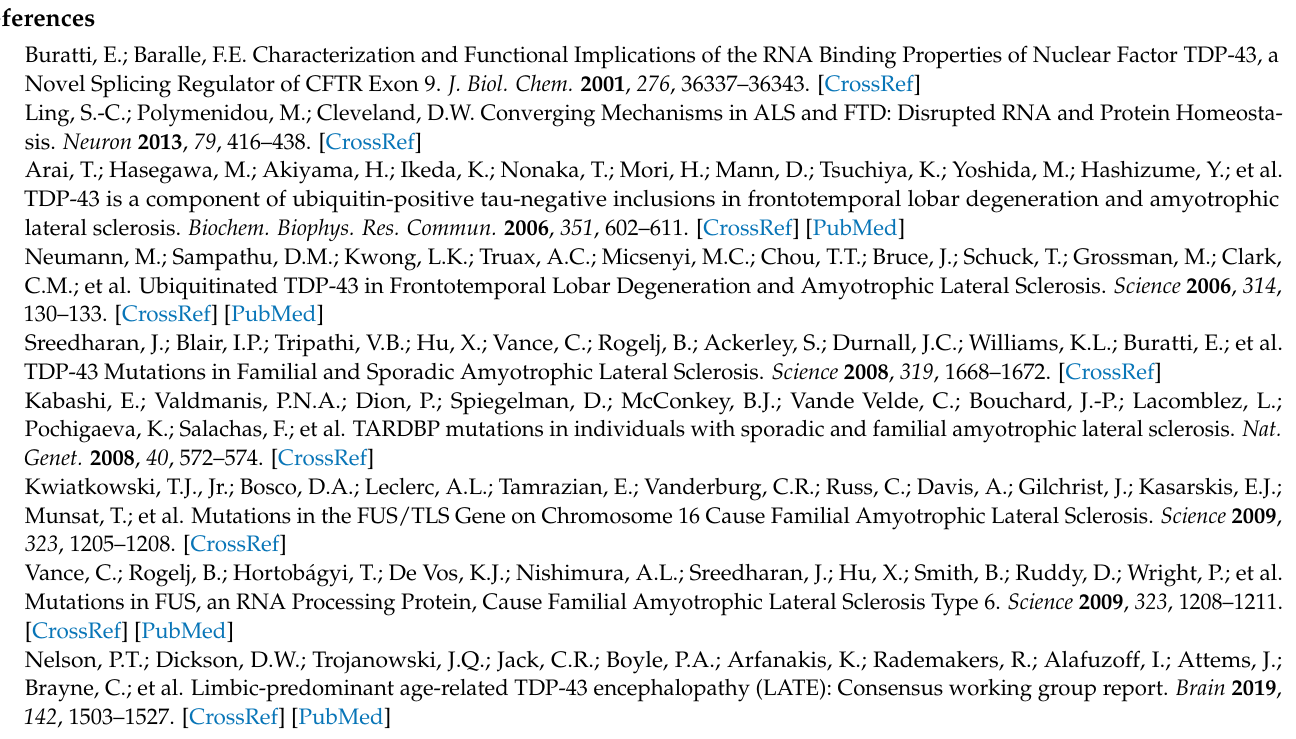
Figure 3; Figure S4: OD600 and ThT graphs for TDP-43 LCD peptides alone in LLPS+ and LLPS- buffers; Figure S5: Effect of 1,6-hexanediol on phase separation and solubility of TDP-43 LCD; Figure S6: Determination of seeding in the absence and presence of a molecular crowder, Table S1: Buffer details used in the buffer